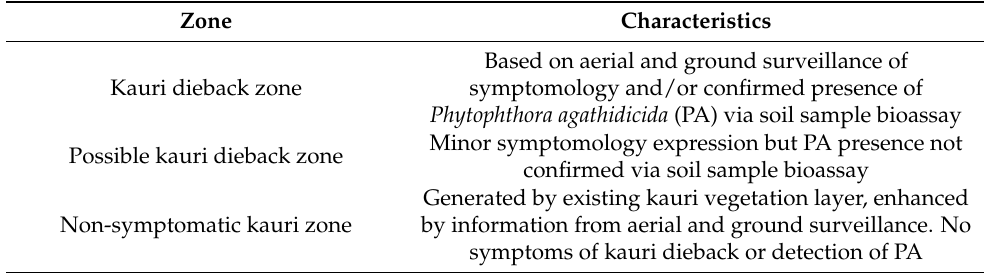
Table 1. Description of the characteristics used to determine kauri dieback zone